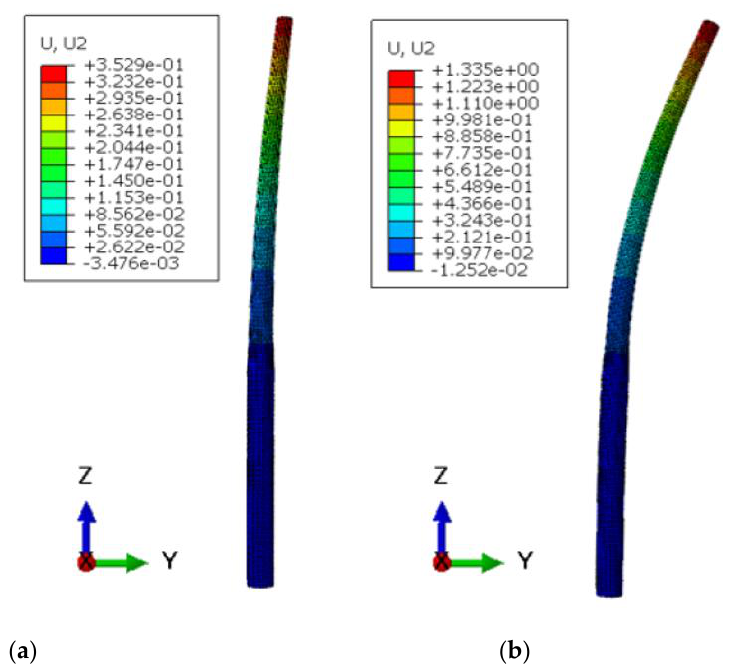
Figure 12. Lateral displacement: ( a ) Normal conditions, ( b ) Extreme sea state.